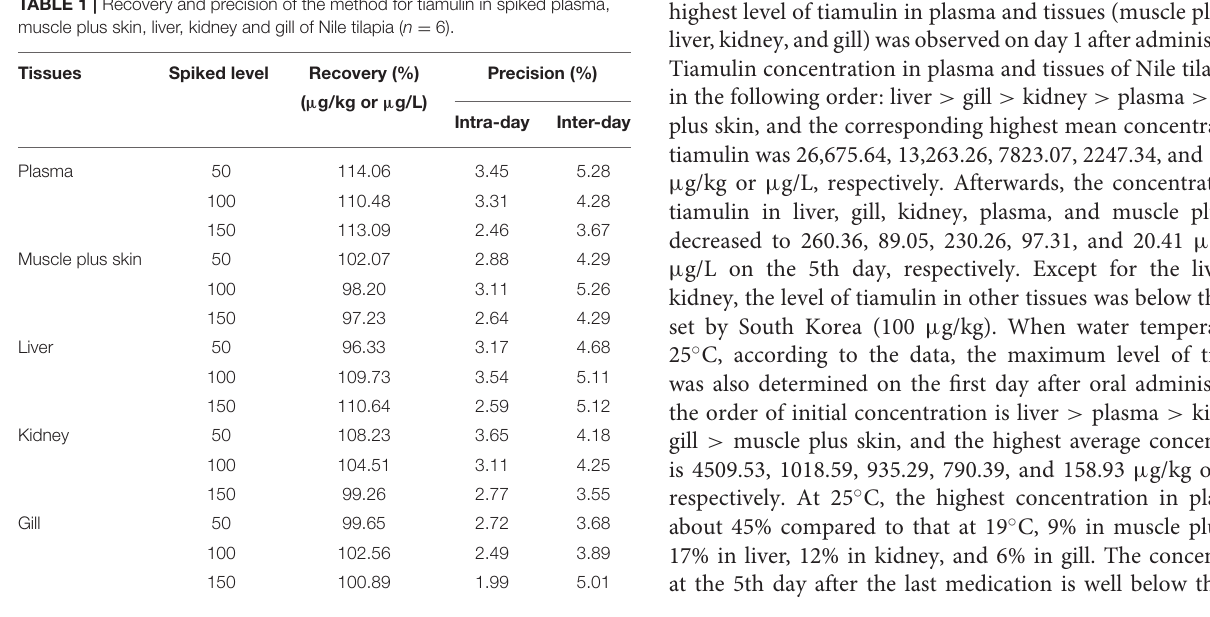
Muscle plus skin